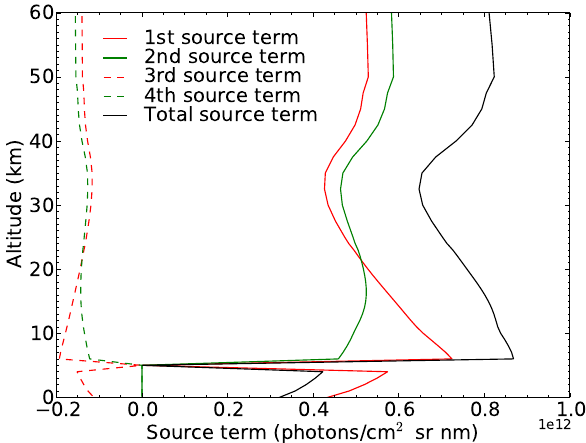
Fig. 1. The total RRS source term Q 0 (τ λ ,µ i ) in Eq. (6) (black line) and the individual terms on the right hand side of Eq. (6) in the order they occur. The source is shown for a quadrature angle µ i = 0 . 02. The shape of the full source and source terms are similar for the other quadrature angles. The wavelength is 393.37nm, close to the center of the calcium K line. A water cloud of optical depth 10.0 is included between 5 and 6km. The solar zenith angle is 33 ◦ and the surface albedo is